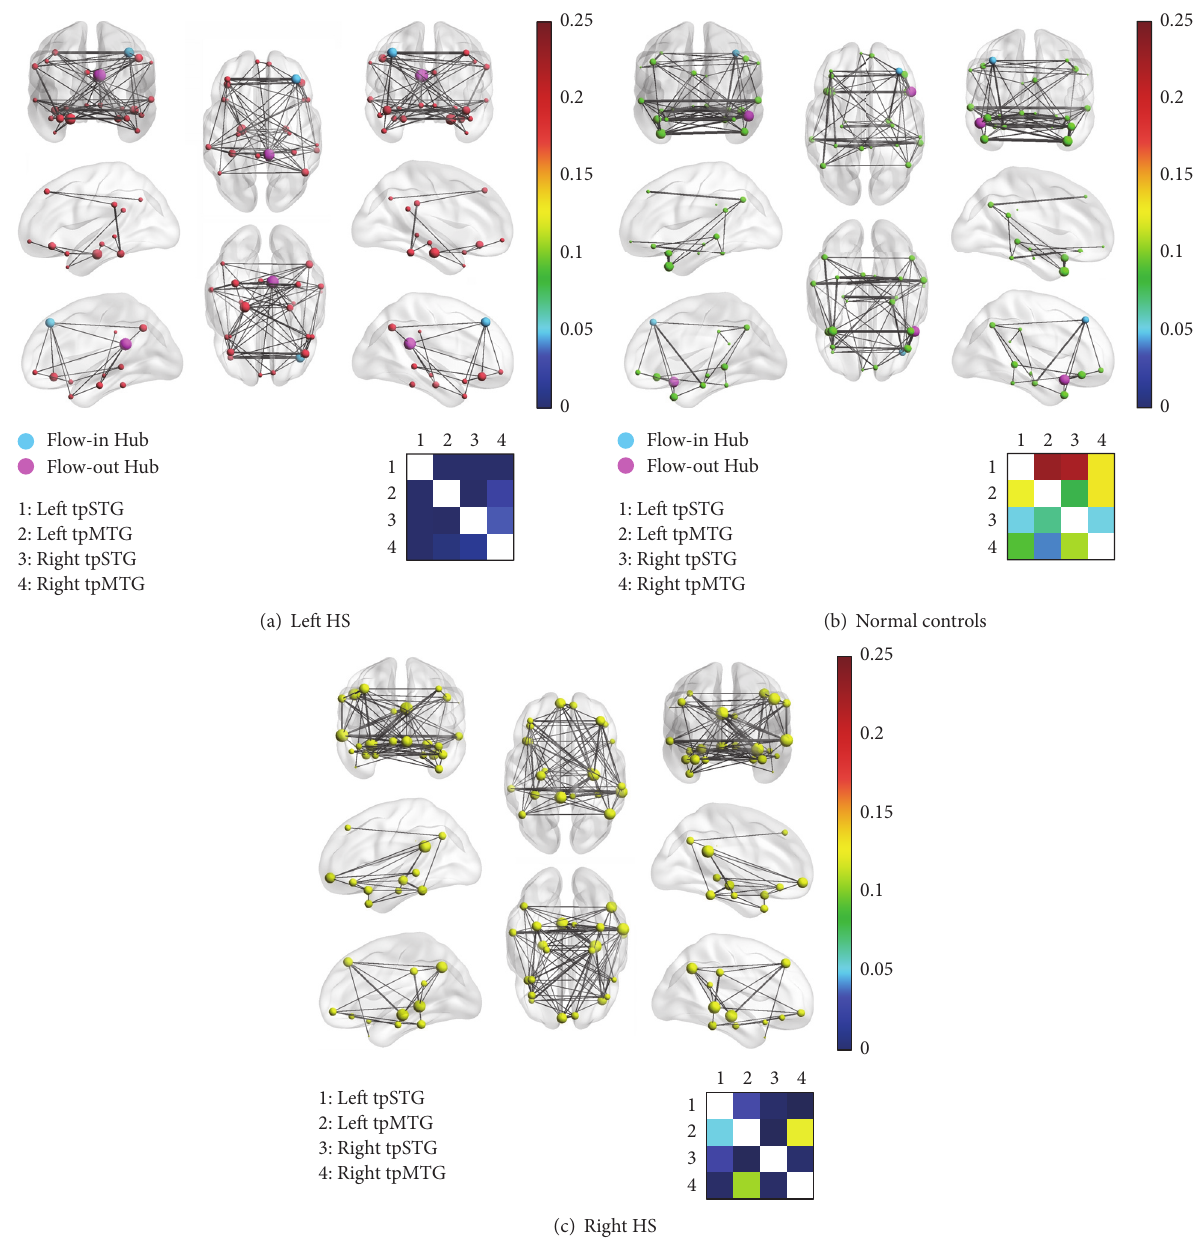
Figure 3: Causal influence of effective connectivity between ROIs in the semantic cognition network. (i) Connection density among the three groups of left HS patients, right HS patients, and normal controls was not significantly different from each other. (ii) The network hub in the normal controls was the right tpMTG (the flow-in hub the right dmPFC and the flow-out hub the right tpMTG), and the network hub in the left HS patients was the right PCC (the flow-in hub the right dmPFC and the flow-out hub the right PCC), but there was no hub node in the semantic cognition network of patients with right HS. (iii) Subregions of the anterior temporal lobe (ATL) in the bilateral hemispheres were strongly connected in normal controls but partially interconnected in right HS patients and not interconnected in left HS patients.